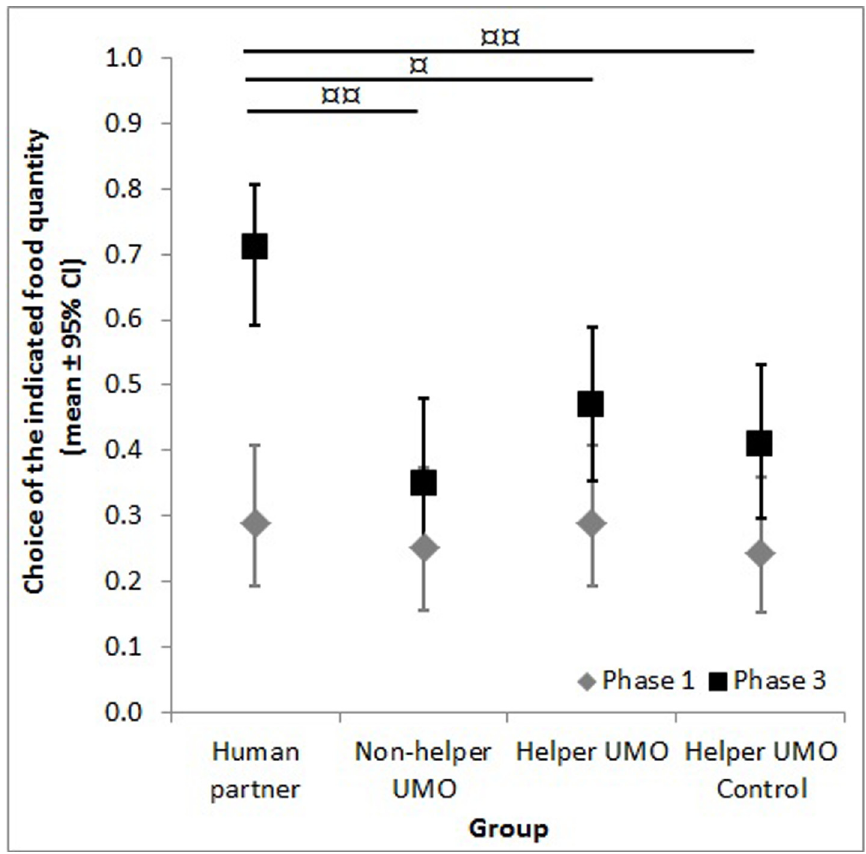
Fig 2. Choice of the small food quantity in Phase 1 and 3. Data are only from dogs who chose the larger quantity more often (Phase 1) and the partner indicated the small food quantity in Phase 3; * shows the difference between phases, ¤ shows the difference between groups in Phase 3 ( * p < 0.05, ** p < 0.001, ¤ p < 0.01, ¤¤ p < 0.001).